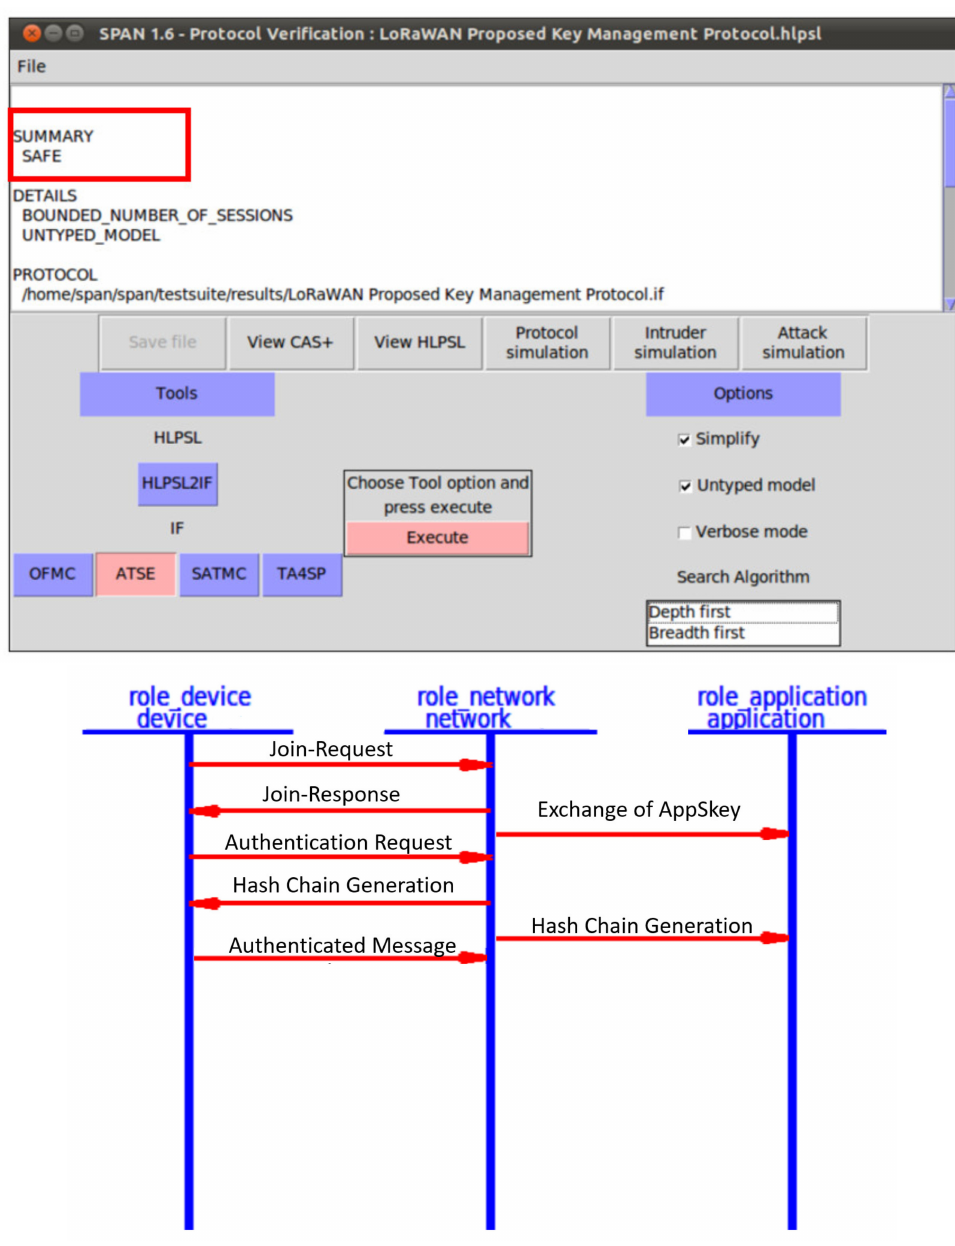
Figure 13. The proposed protocol security verification and message sequence using